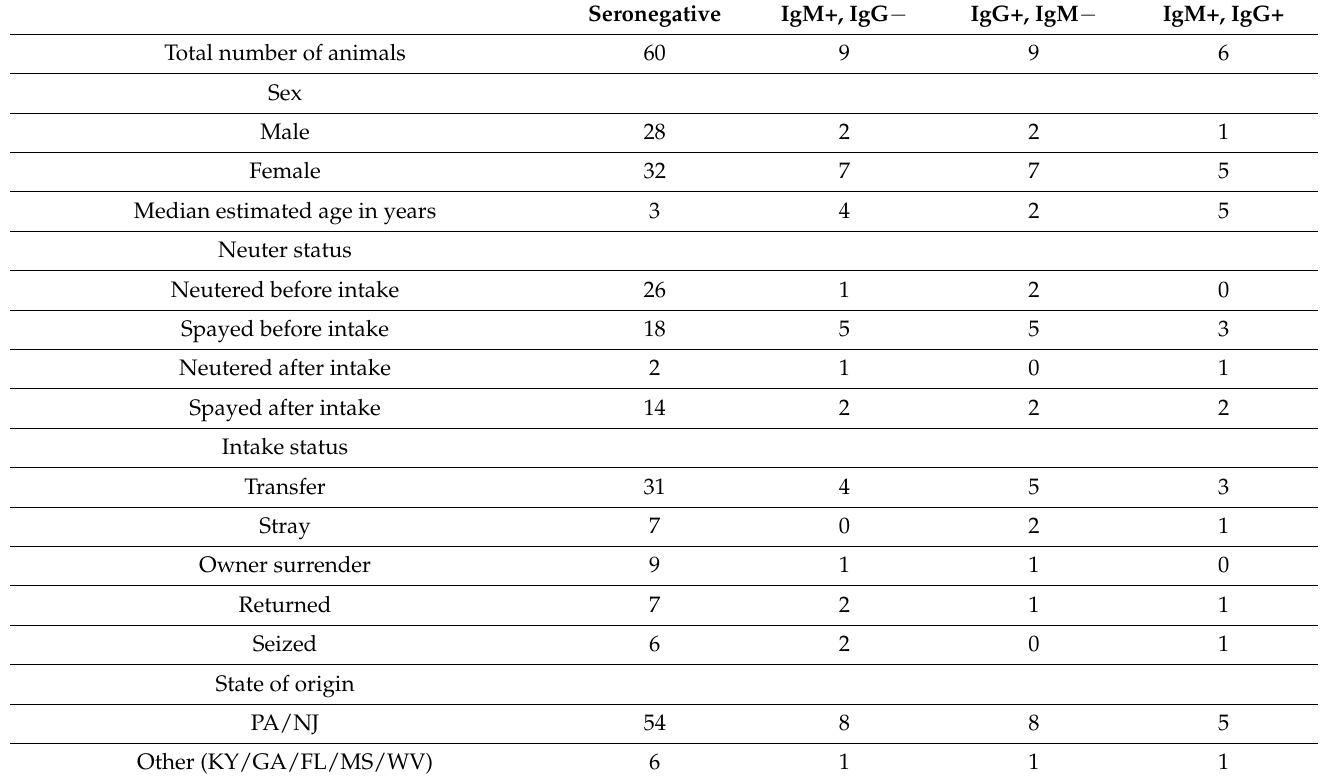
Table 2. Numerical counts of felines within each risk factor group that were seropositive for IgM, IgG, or both IgM and IgG. Seronegative IgM+, IgG − IgG+, IgM − IgM+, IgG+ 60 9